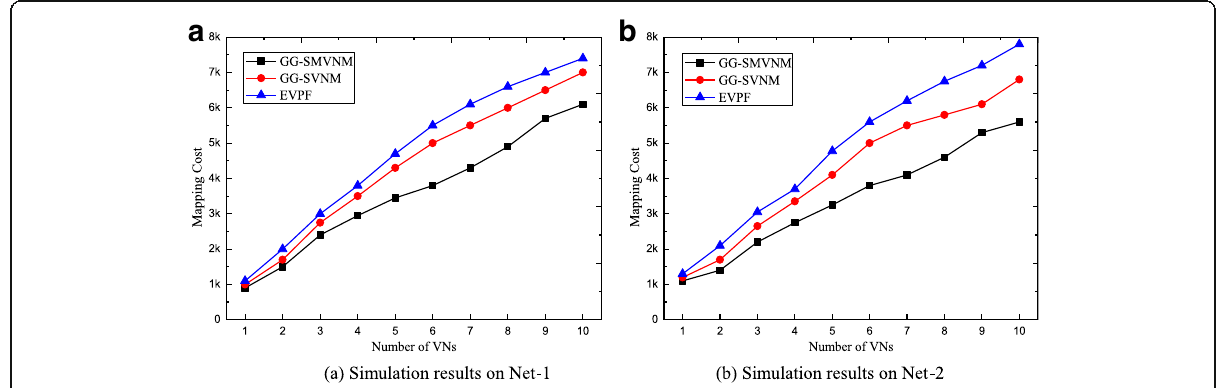
Fig. 6 Mapping costs vs. number of VNs. a Simulation results on Net-1. b Simulation results on